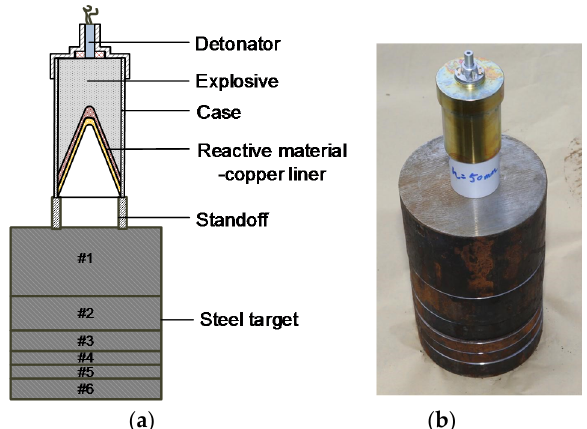
Figure 4. Schematic and photograph of the experimental setup. ( a ) Experimental schematic; ( b ) Experimental setup.